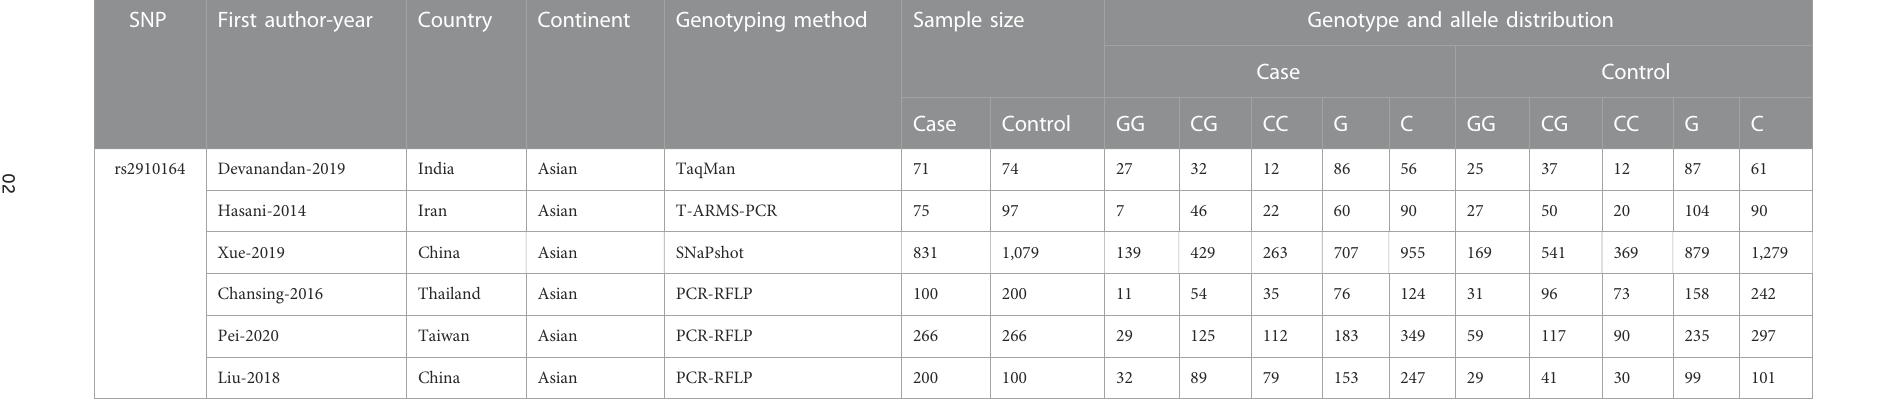
TABLE 1 Characteristics of six studies included in the present